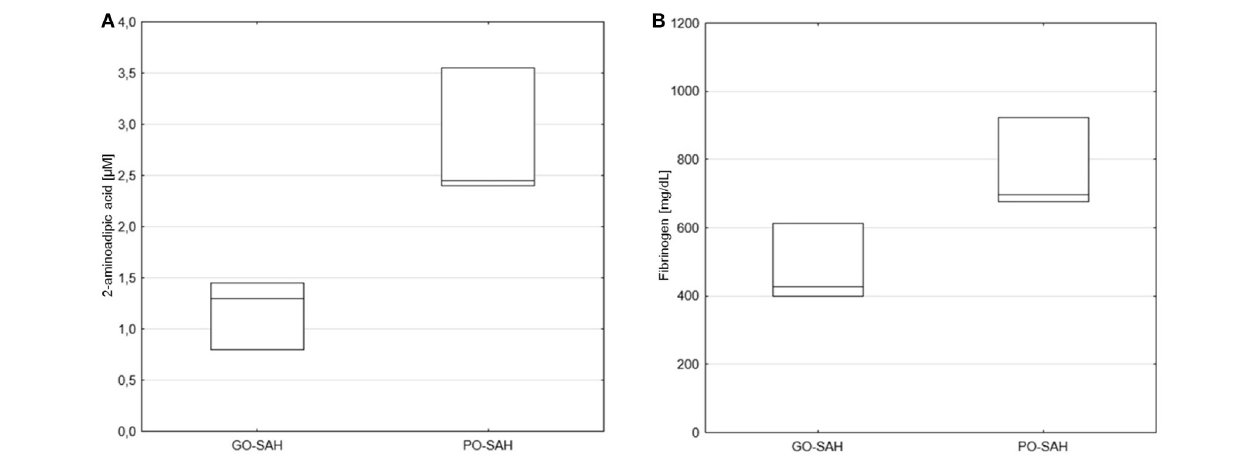
FIGURE 3 | Significant differences in monitored parameters on day 10 post-SAH between patients with good (GO-SAH) and poor (PO-SAH) treatment outcome. Mann–Whitney test revealed significantly higher 2-aminoadipic acid ( p = 0.033) (A) and fibrinogen ( p = 0.014) (B) levels in patients with poor outcome. Median levels and the 25th and 75th percentile are